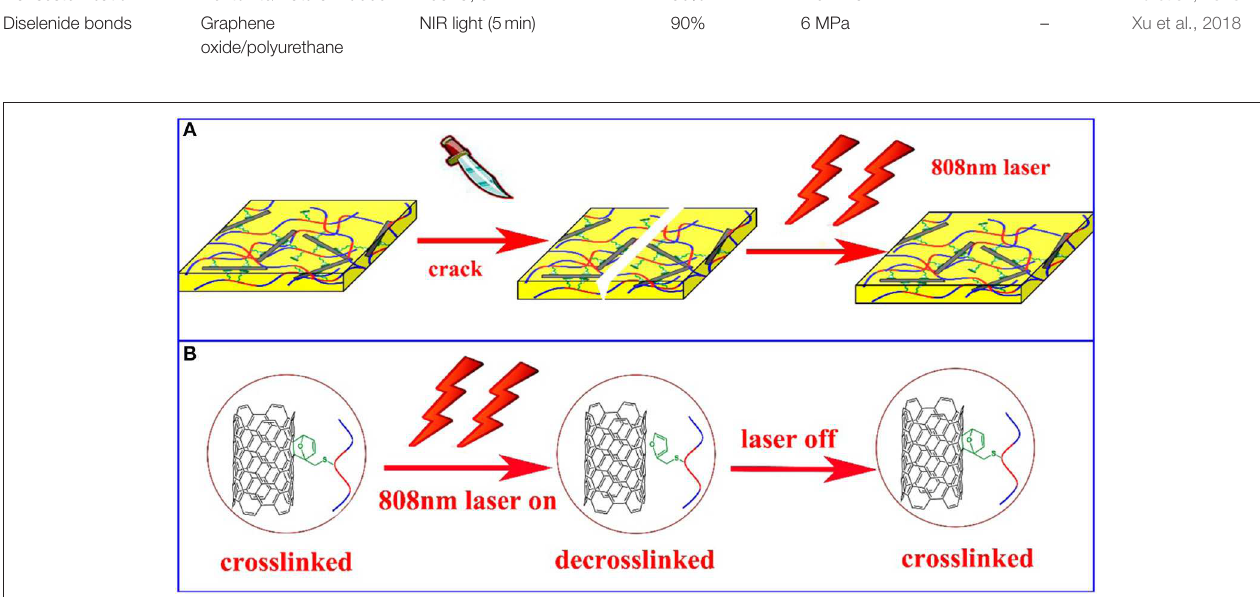
FIGURE 6 | (A) Healing Process of the Sample; (B) Reaction Occurring during the Healing Process (Bai and Shi, 2017). Reproduced with the permission of 2017 American Chemical Society.